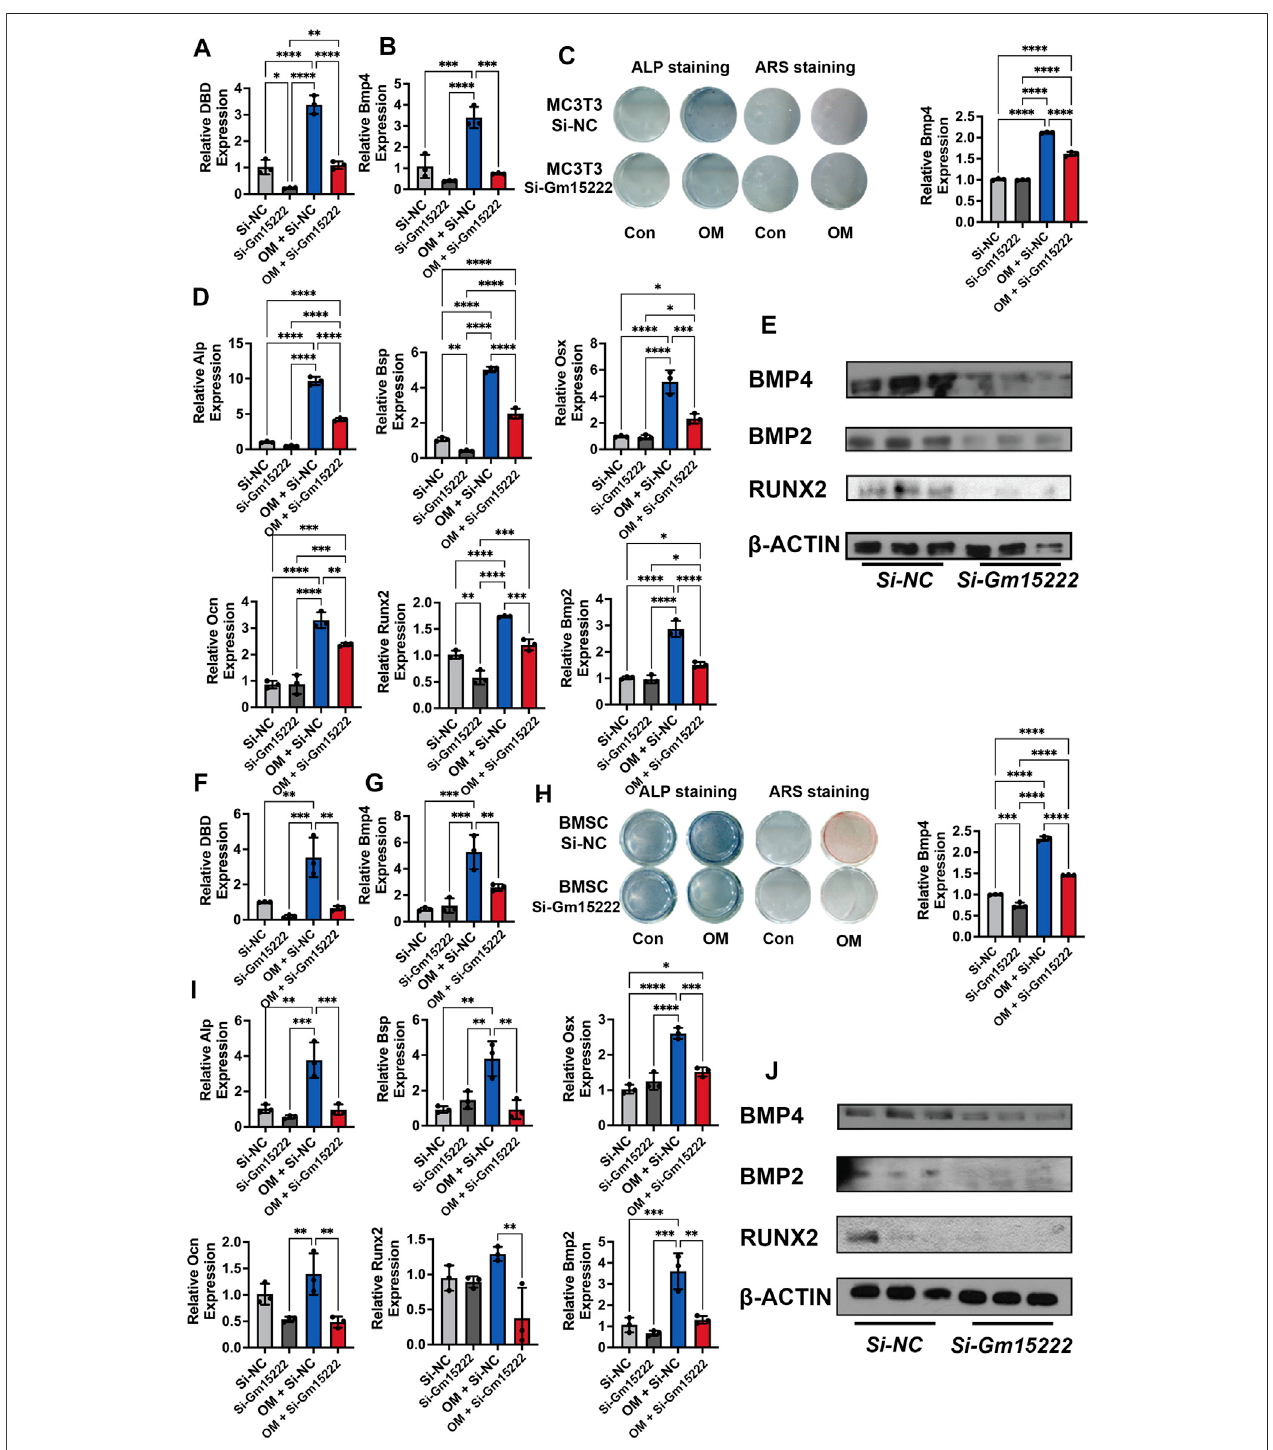
FIGURE 3 | lncRNA Gm15222 upregulates the expression of Bmp4 and promotes osteoblast differentiation. (A) The interference ef fi cacy of si-Gm15222, as detected by qRT-PCR in MC3T3-E1 cell line treated with or without mineralization medium, n = 3 [OM, ascorbic acid (50 μ g/ml), 5 mM β -glycerophosphate]. Si-NC, siRNA negative control; Si-Gm15222, Gm15222 siRNA; OM, osteogenic medium. (B) The silence of Gm15222 inhibited its neighboring gene Bmp4 expression, as detected by qRT-PCR in MC3T3-E1 cell line treated with or without mineralization medium and si-Gm15222, n = 3. (C) The silence of Gm15222 impaired its neighboring gene Bmp4 expression as detected by ALP staining and Alizarin red R staining in MC3T3-E1 cell line treated with or without mineralization medium: the left twocolumnsofplatesweredetectedbyalkalinephosphatase(ALP)staining;andtherighttwocolumnsofplatesweredetectedbyAlizarinRedS(ARS)staining;theright